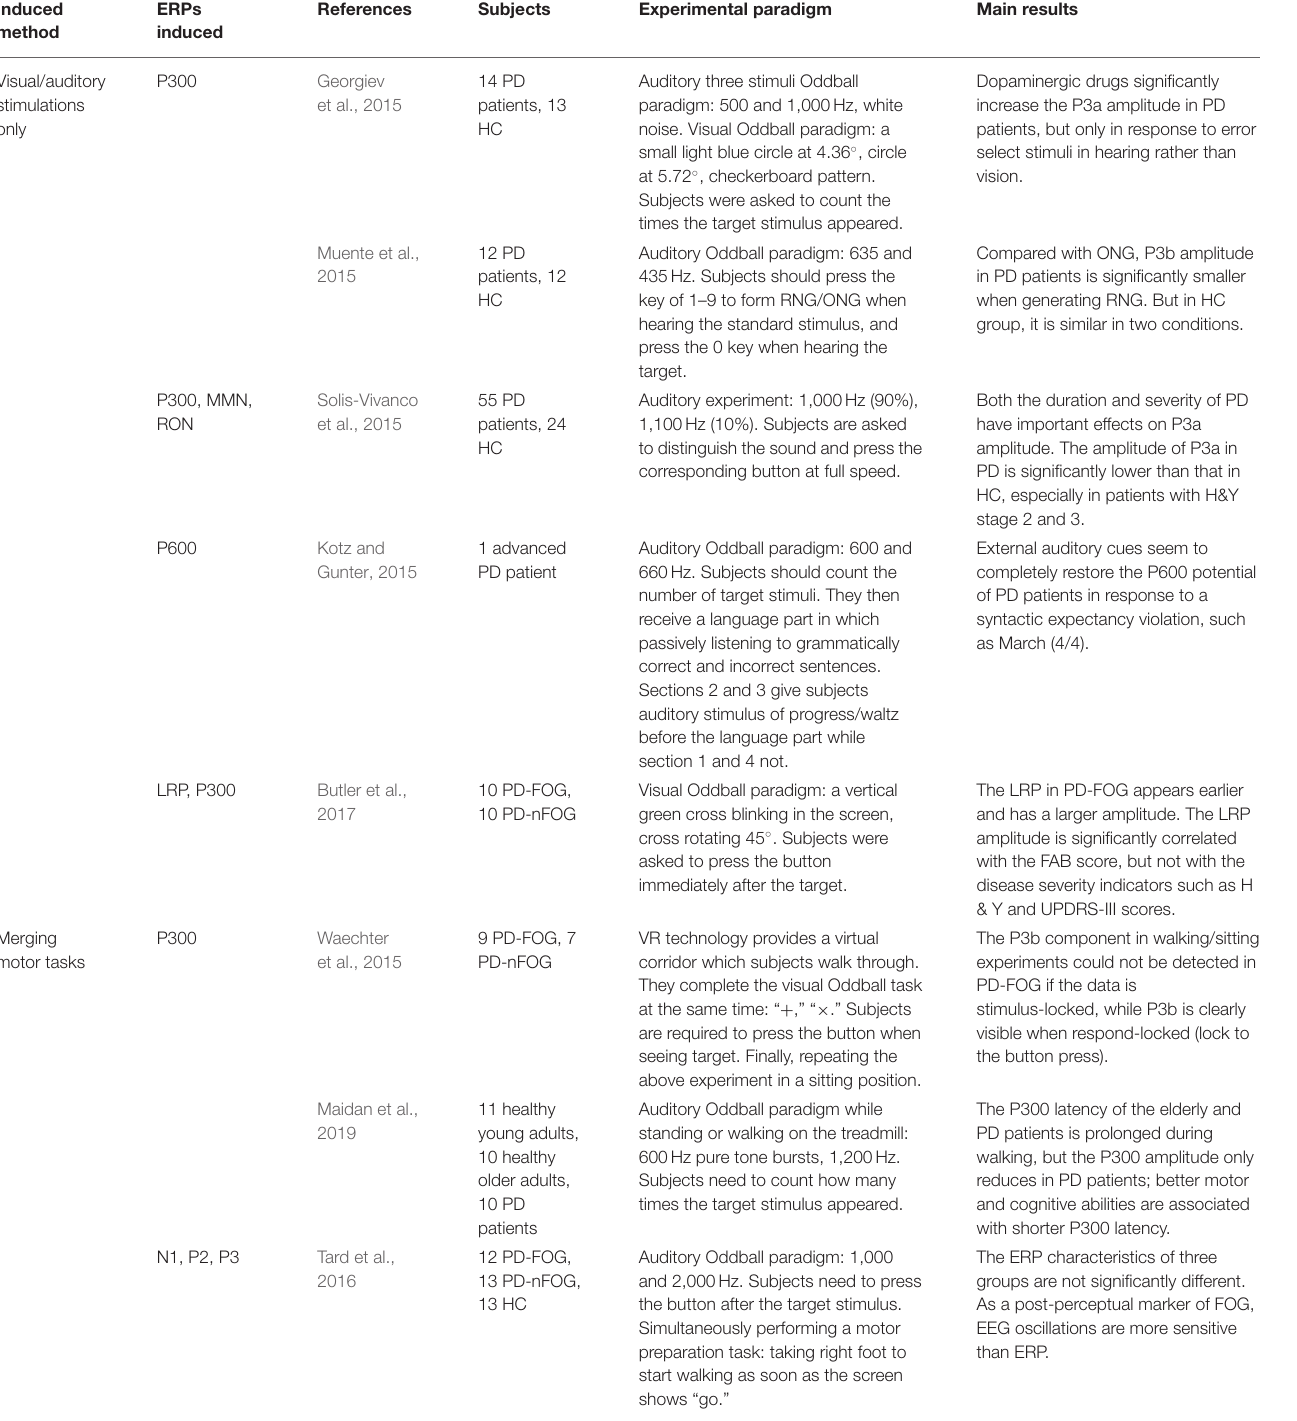
TABLE 2 | Summary of experimental paradigms and main results of induced